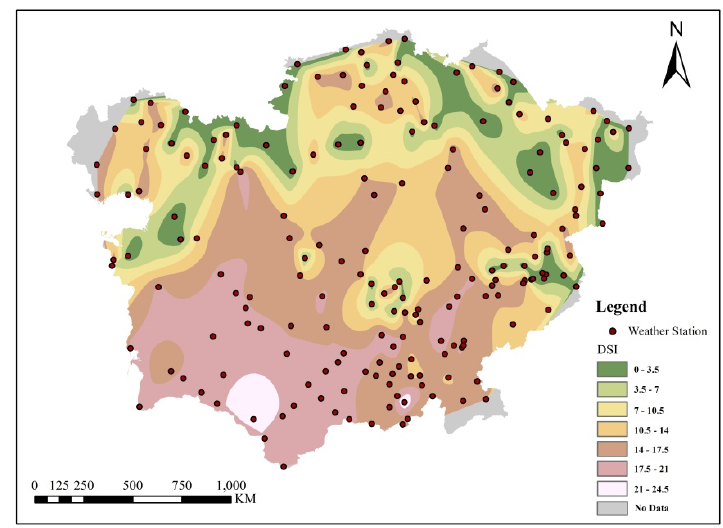
Figure 10. The location of weather stations that provide visibility records and the annual mean Dust Storm Index (DSI) for the period 2000 to 2019 across CA.